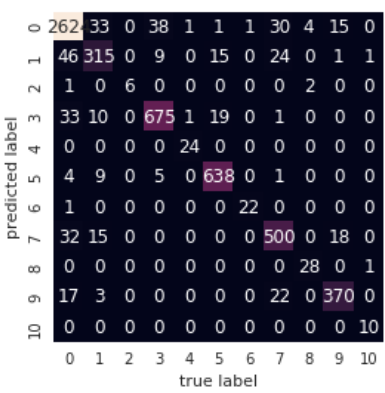
Figure 14. Confusion matrix of Decision Tree model for classification ON/OFF label.